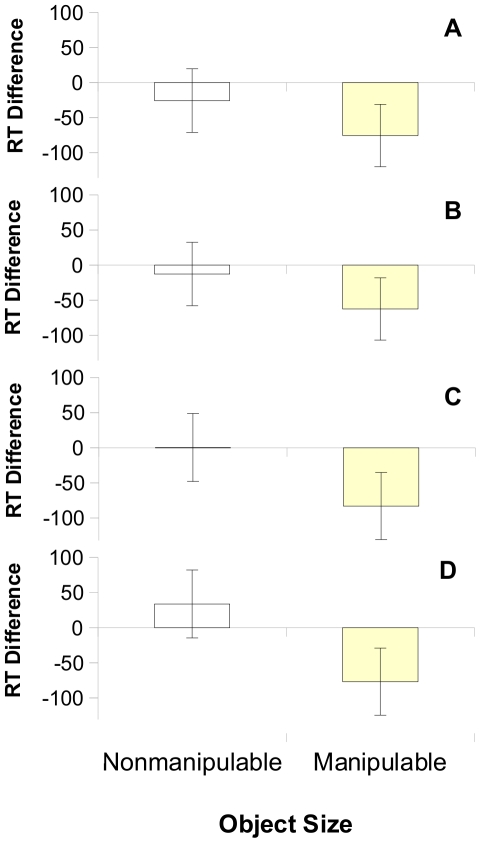
Size judgement effects (in ms) for tactile stimulation (a: bigger judgements; N = 20, b: smaller judgements; N = 21) and proprioceptive stimulation (c: bigger judgements; N = 23, d: smaller judgements; N = 22), showing consistent facilitation for small, manipulable objects but not for large, nonmanipulable objects.RT difference was calculated by subtracting judgement times in the control foot-stimulation condition from judgement times in the critical hand-stimulation condition. Error bars show 95% confidence intervals of the difference between means.